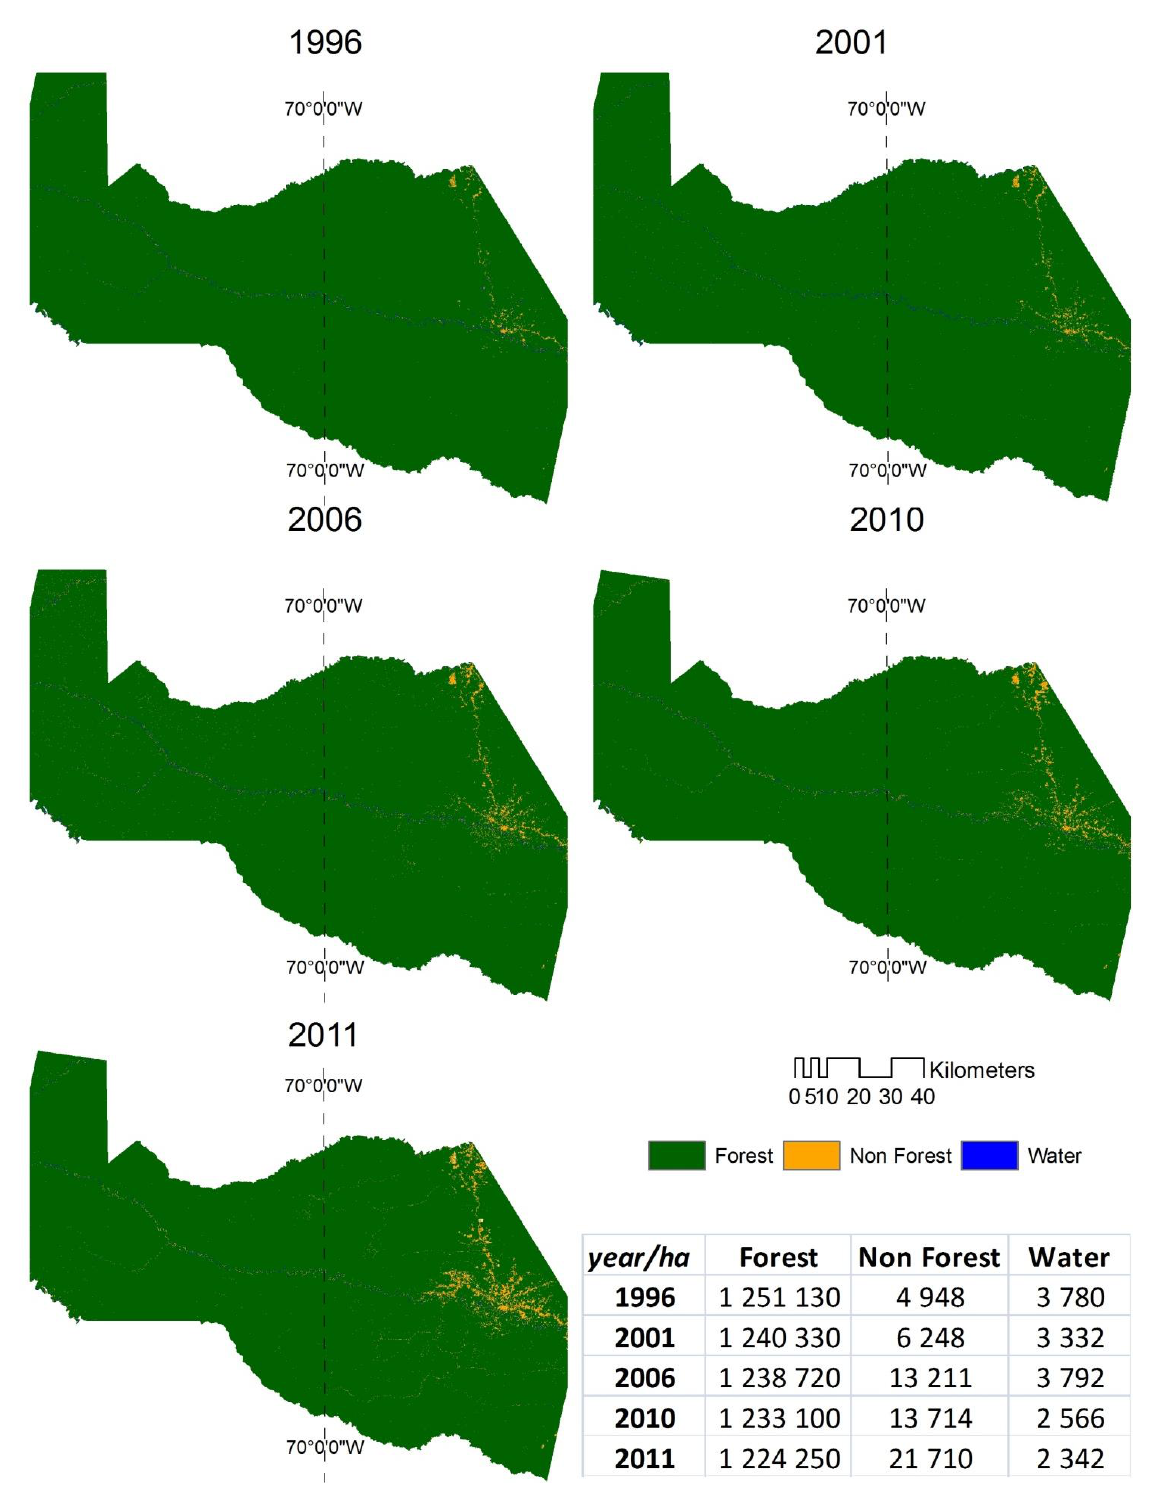
Figure 5. Forest, non-forest and water class maps for 1996, 2001, 2006 and 2011 for the Province of Tahuamanu. Areas of each class (in ha) are provided in the accompanying